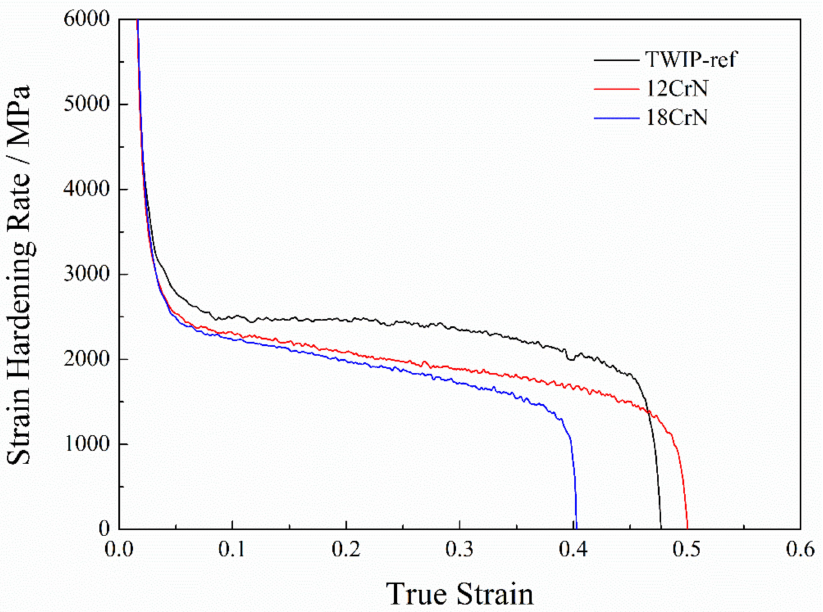
Figure 7. Strain-hardening rates against true strain of Fe–Mn–Cr–CN and TWIP-ref